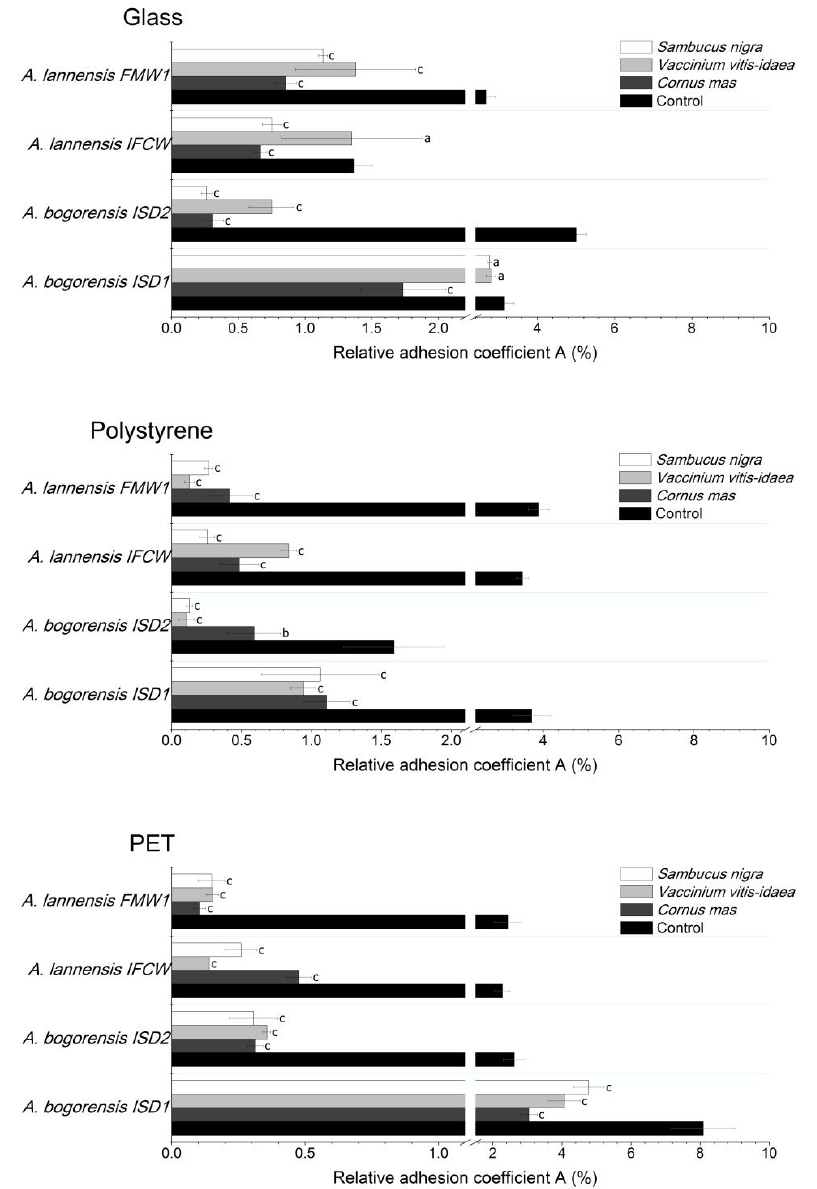
Figure 2. Adhesion of Asaia strains ( Asaia lannensis and Asaia bogorensis ) to glass, polystyrene and polyethylene terephthalate (PET) in minimal medium with addition of 10% elderberry, lingonberry and cornelian cherry. Results are expressed as relative adhesion coefficient A(%). Values are means of three determinations ± standard deviation. Values with the different letters are statistically different ( p < 0.05). a— p ≥ 0.05; b—0.005 < p < 0.05; c— p < 0.005; The results were compared to those received for a control